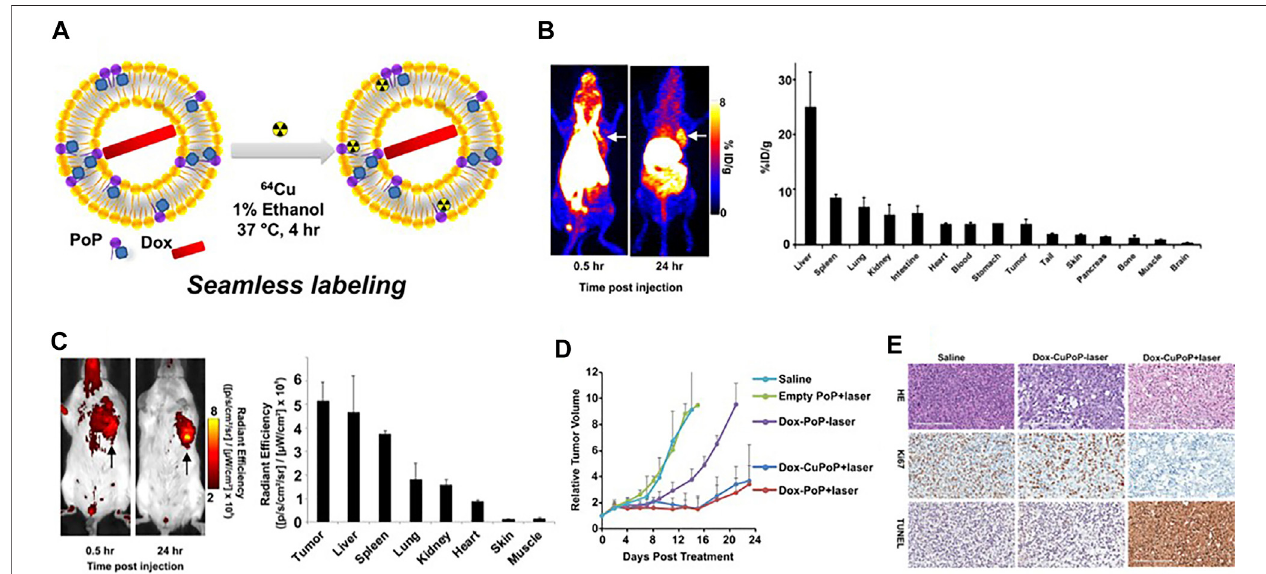
FIGURE 4 | (A) Preparation of Dox-loaded CuPoP liposomes. (B) In vivo PET imaging and gamma counting – based biodistribution of Dox-CuPoP. (C) FI and quantitative fl uorescence signal of mice bearing orthotopic 4T1 mammary tumors using Dox-CuPoP. (D) Relative tumor growth in mice bearing orthotopic 4T1 tumors after different treatments. (E) HE, Ki67, and TUNEL stainingof tumor slices from mice receiving the indicated treatments. Reproduced with permissionfrom LuoD. et al. (2017). Copyright 2017, American Chemical Society.